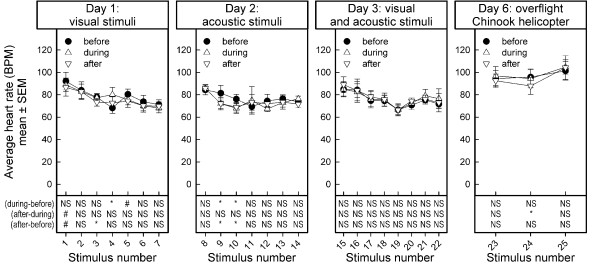
Average heart rate before, during, and after stimulus presentation in 5 dairy goats. Heart rate (beats per minute, BPM) is depicted as mean ± SEM. Note that during the overflight of the Chinook helicopter, only the heart-rates of four goats were registered reliably. The list of stimuli presented is shown in Table 1. Results of one-sample t-statistics on the difference scores between values (during minus before), (after minus during), and (after minus before) stimulus presentation are summarized in the lower part of the figures. NS: no effect, p > 0.10; #: marginal effect, 0.10 > p > 0.05; *: effect, p < 0.05